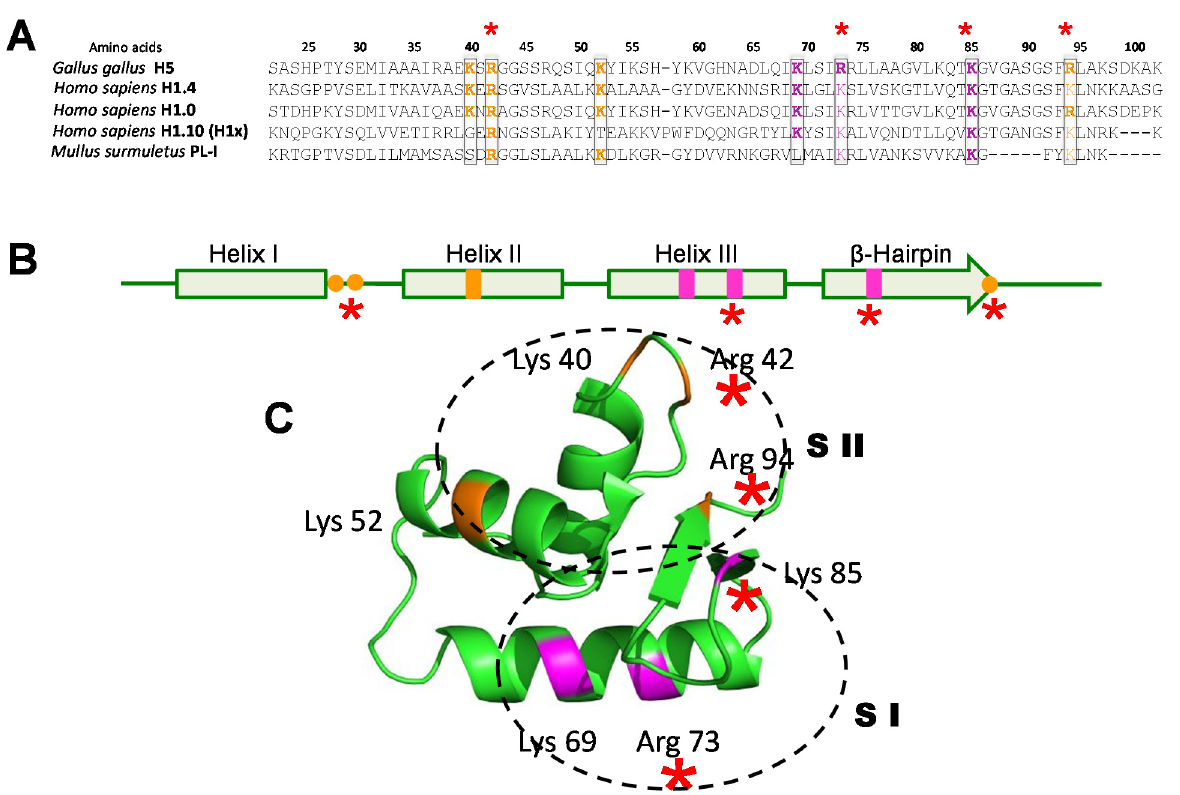
Figure 6. ( A ) Amino acid sequence alignment of the WHD regions of several linker